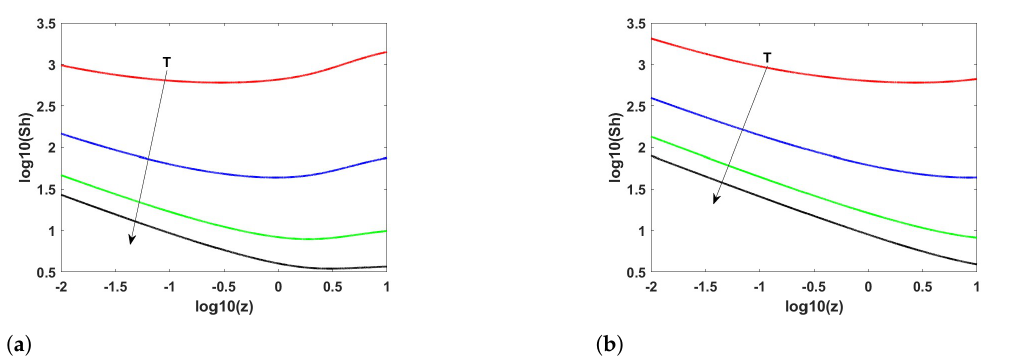
Figure 1. Sherwood number along the length of the reactor at temperatures of 400, 500, 600, and 700 ◦ C and 1 atm evaluated from Equation (28) at Pe = 10 ( a ) and 100 ( b